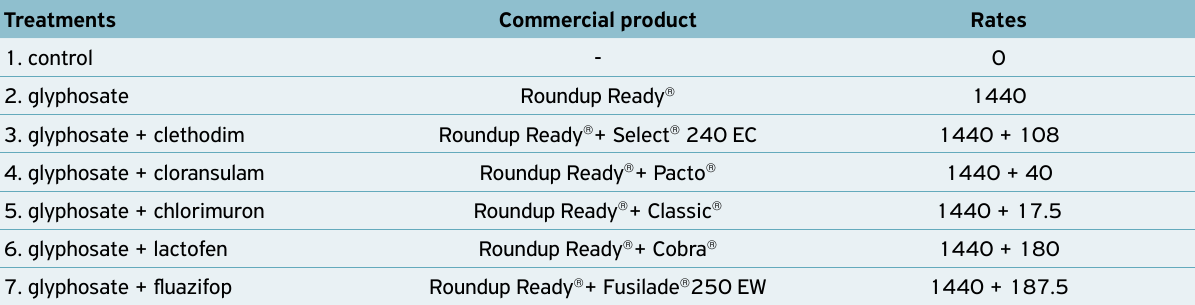
Table 2. Treatments applied post‑emergence (V4) of RR2 soybeans in 2013/14 and 2014/15 seasons. Piracicaba, state of São